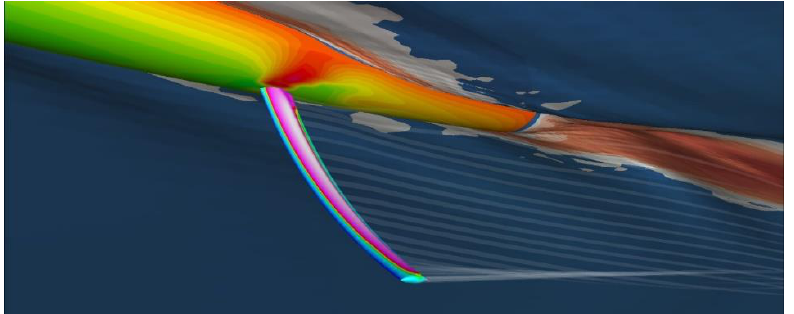
Figure 9. Example of a CFD solution of the hull with appendage used to fine tune the foils analytical models.